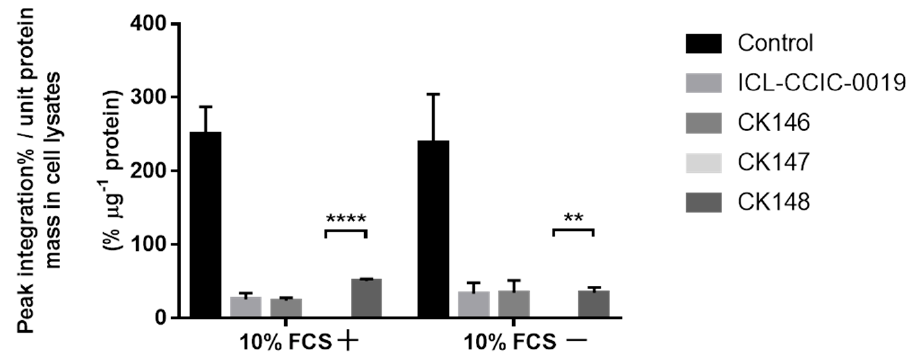
and CK148 in medium with or without FCS ( n = 3, mean ± SD). The data were calculated from chromatographic peak integration normalized to protein amount in cell lysates. p Values via unpaired two-tailed t -test: **** p < 0.0001, ** p <